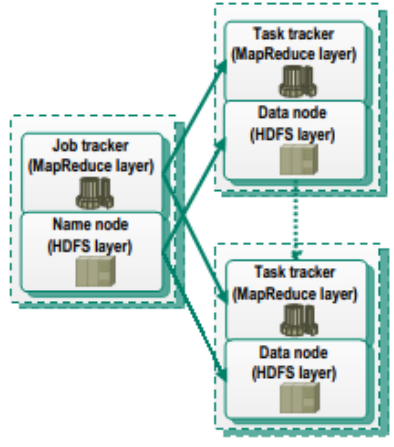
Figure 16. Hadoop V1.x